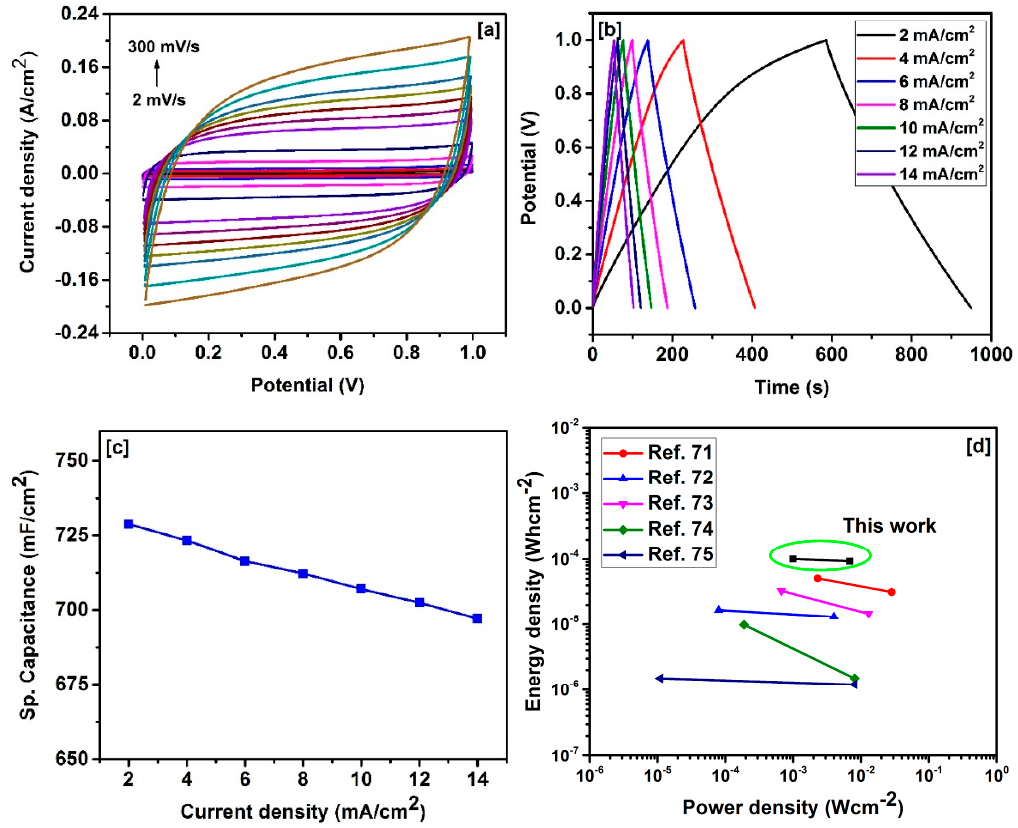
Figure 6. ( a ) CV curves at various scan rates, ( b ) GCD profiles at different current densities, ( c ) specific capacitances at different current densities of supercapacitor based on OPAC-1, and ( d ) Ragone plot comparing OPAC-1 to previous reports.